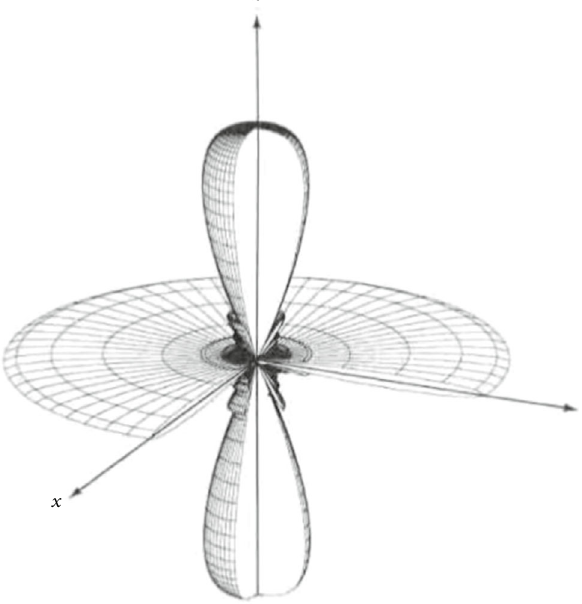
Figure 1: Three-dimensional amplitude patterns for broadside/end- fi re arrays. Image source: Constantine A. Balanis Antenna Theory Analysis and Design. John Wiley and Sons